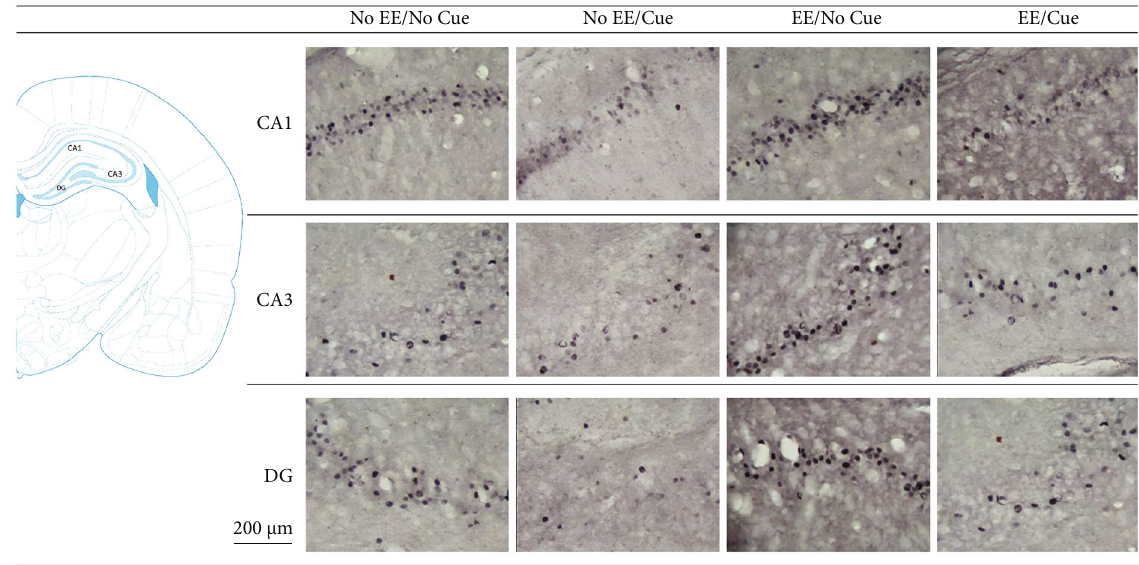
Figure 12: (a) A schematic brain atlas for the Cg1, CA3, and DG of the hippocampus. (b) Representative photomicrographs of the c-Fos expression for the CA1, CA3, and DG of the hippocampus in the no EE/no cue, no EE/cue, EE/no cue, and EE/cue groups ( n = 4 , per group). Scale bar represents 200 μ m. Table 3: E ff ects of environmental enrichment and cue for PTSD in the normalized c-Fos mRNA expression for selected brain areas in the situational reminder phase. mPFC NAc Amygdala Hippocampus Environmental